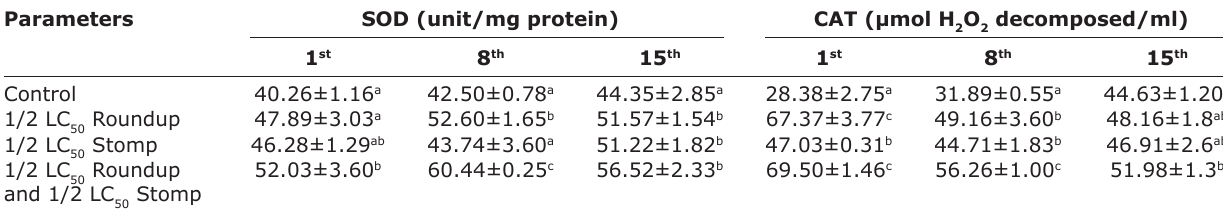
Table-2: Changes in SOD and CAT activities of C. gariepinus exposed to Roundup, Stomp, and both at 1 st , 8 th , and 15 th days of exposure (mean±SE) (n=30). Parameters